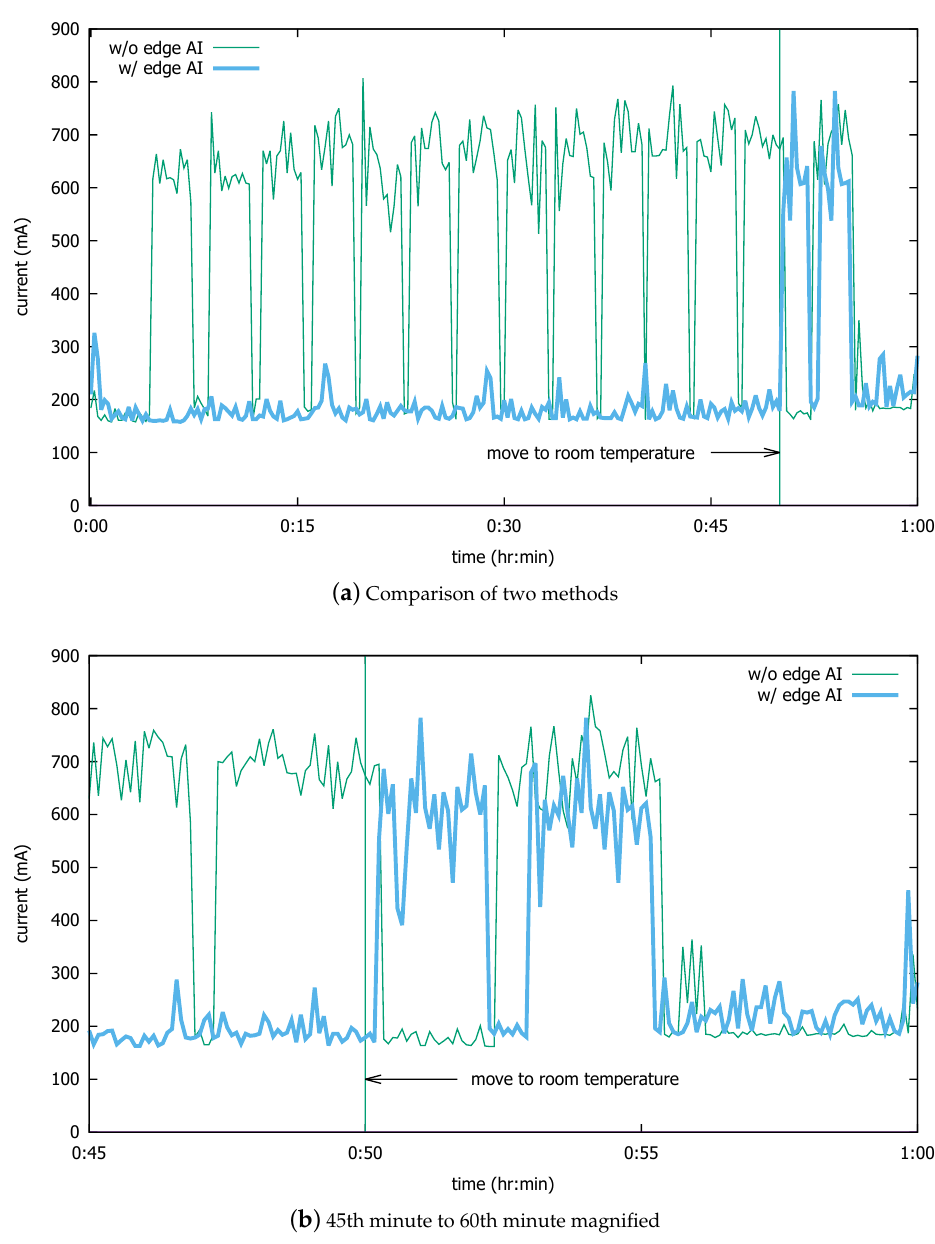
Figure 14. Comparison of current dissipation with and without the edge